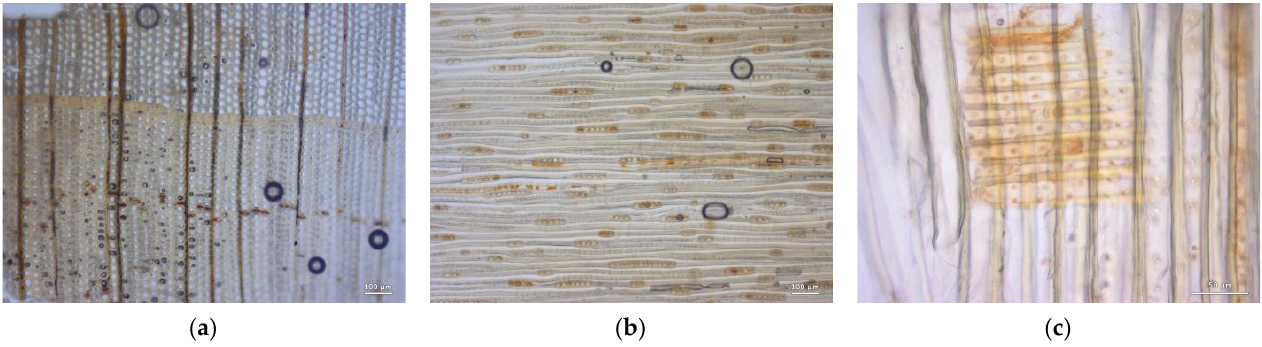
Figure 22. Sections characteristic of sample SO1, identified as belonging to the Juniperus genus: ( a ) Cross-section; ( b ) Tangential section; ( c ) Radial section.